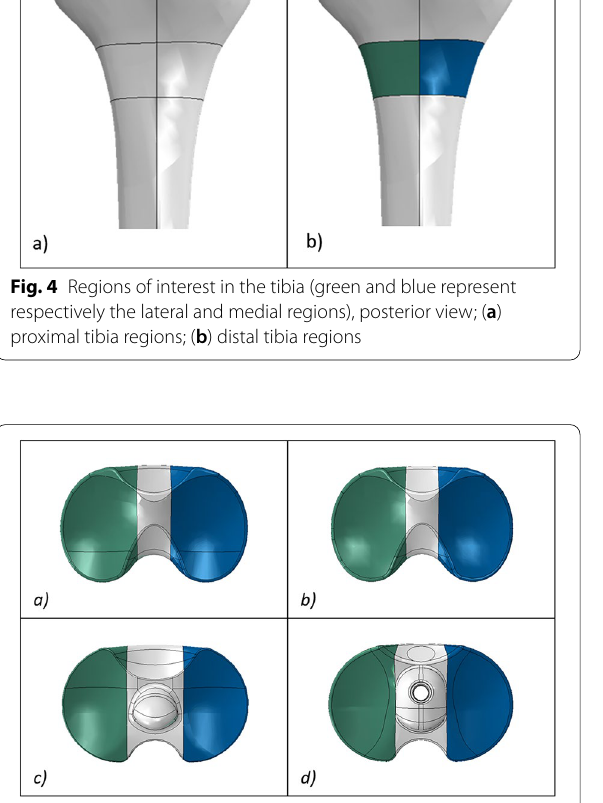
Fig. 5 Regions of interest analyzed for the inserts (green and blue represent respectively the lateral and medial regions); ( a ) MB CR insert; ( b ) MB CR ultra congruent insert; ( c ) FB PS insert, and ( d ) FB CCK